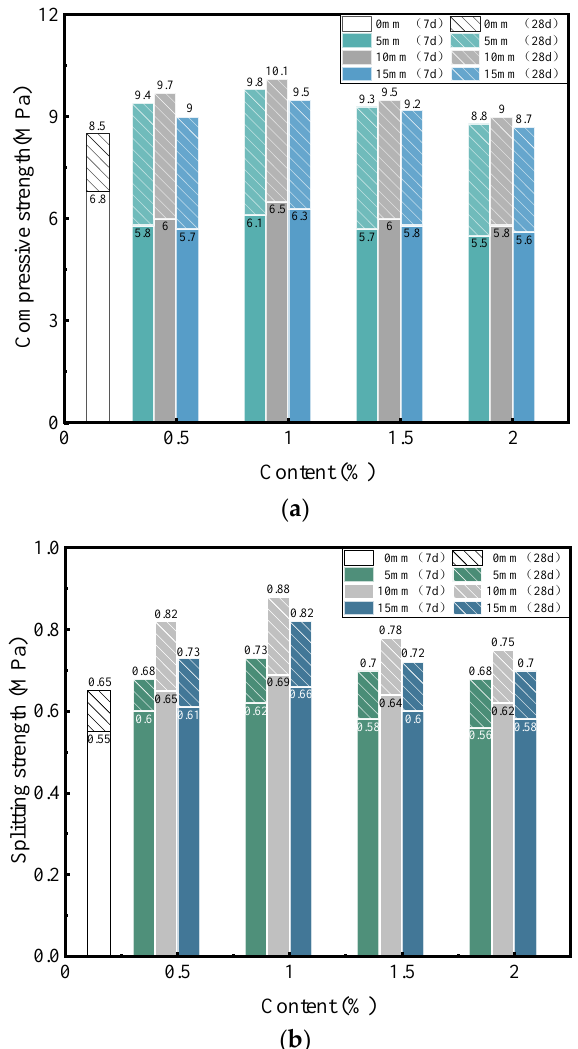
Figure 6. Mechanical strength of cement-stabilized macadam. ( a ) Compressive strength; ( b ) Splitting strength.